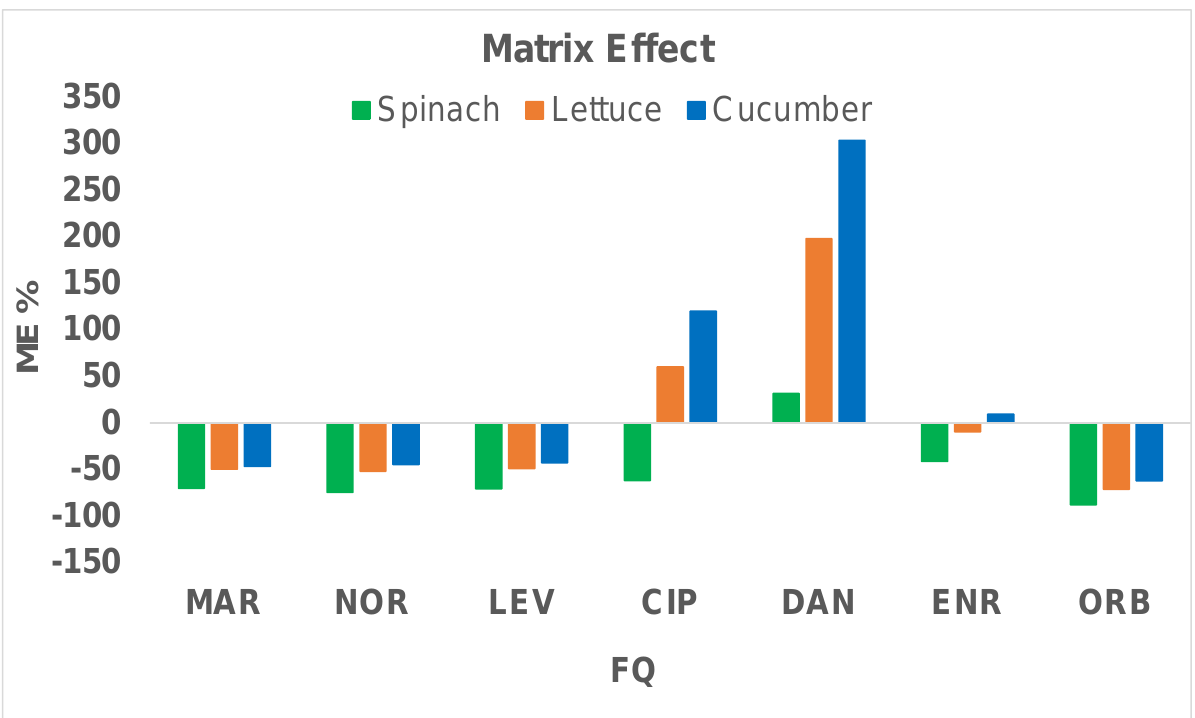
Figure 3. Matrix effect (ME %) for each matrix.